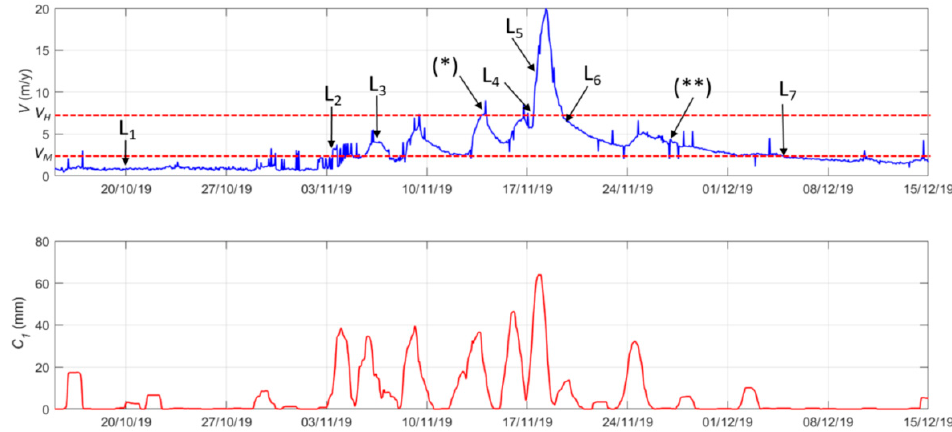
Figure 8. Rainfall and velocity time series from 15 October 2019 to 15 December 2019, where examples of events L 1 -L 7 are highlighted (dates: L 1 20 October, L 2 31 October, L 3 6 November, L 4 17 November, L 5 18 November, L 6 20 November, L 7 5 December. The two horizontal dotted lines correspond to the thresholds V M (2.5 m/y) and V H (7.5 m/y). The event (*) is labeled as a spike (therefore, it is an L 3 event, not an L 4 one), whereas the events such as (**) after 25 November are labeled as L 3 .